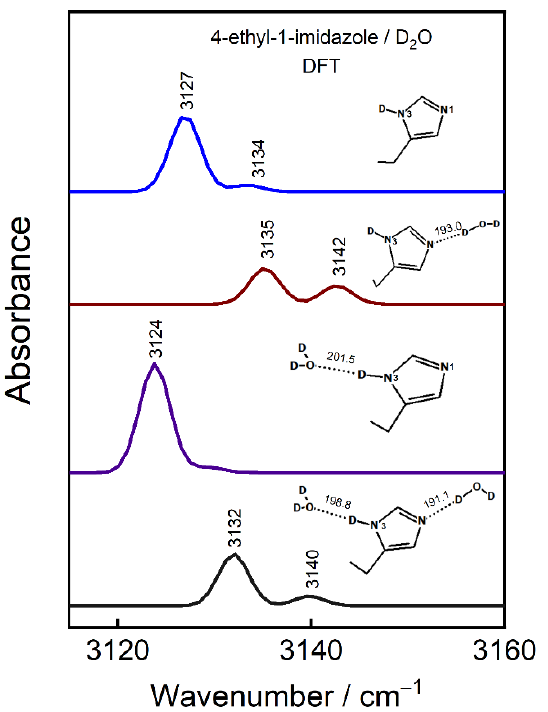
Figure 9. DFT spectra in Im ring =C – H stretching region of 4-ethyl-1-imidazole in T-II form without and with explicit D 2 O molecules at N1 and/or N3 – D. Insets show imidazole ring interactions with D 2 O; for detail 3D representation refer to Figure S7. The hydrogen-bonding lengths are indicated in pm. Vibrational frequencies were scaled.